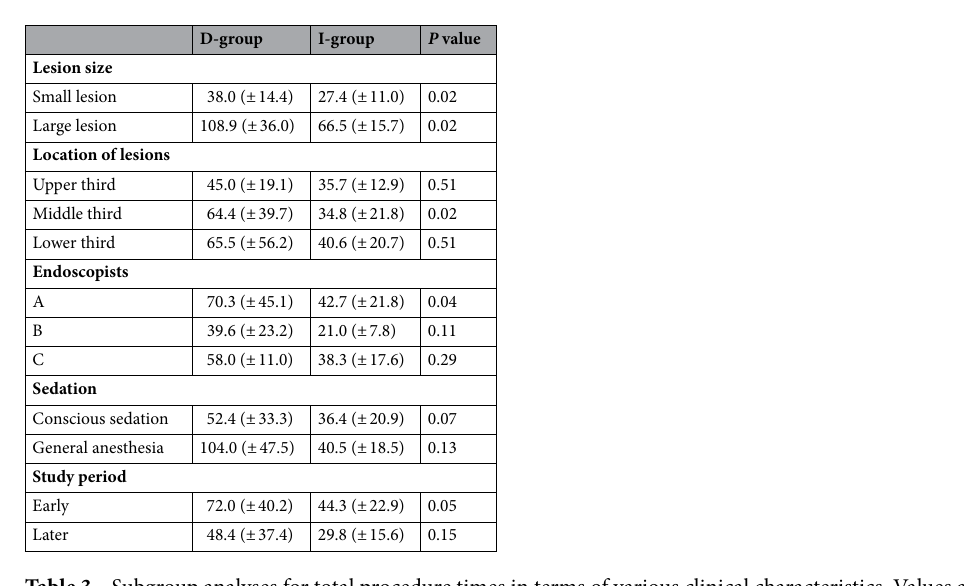
Table 3. Subgroup analyses for total procedure times in terms of various clinical characteristics. Values are mean (± standard deviation). D-group DualKnife group, I-group ITknife nano